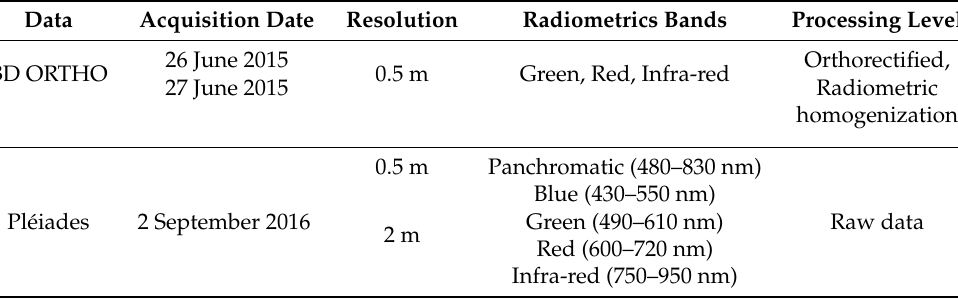
Table 1. Characteristics of the images used in this